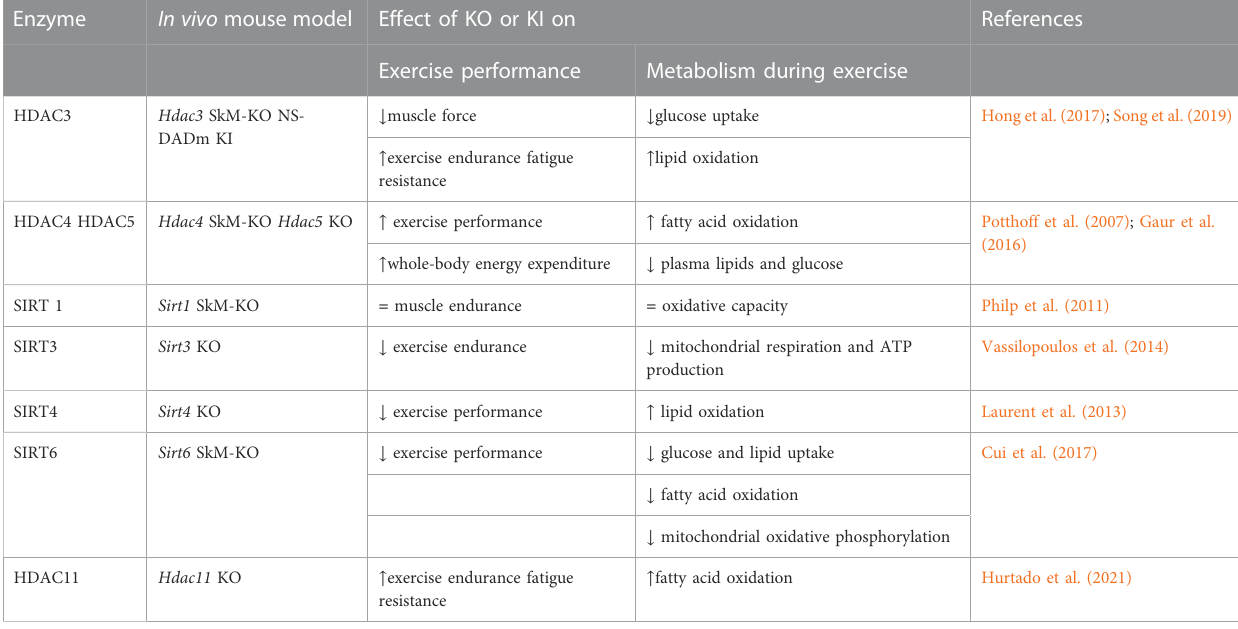
TABLE 1 Role of HDACs in skeletal muscle following exercise identi fi ed by different mouse models. SkM, skeletal muscle, KO, knock out, KI, knock in. All the described genetically engineered mouse models were generated by germline manipulation. Enzyme In vivo mouse